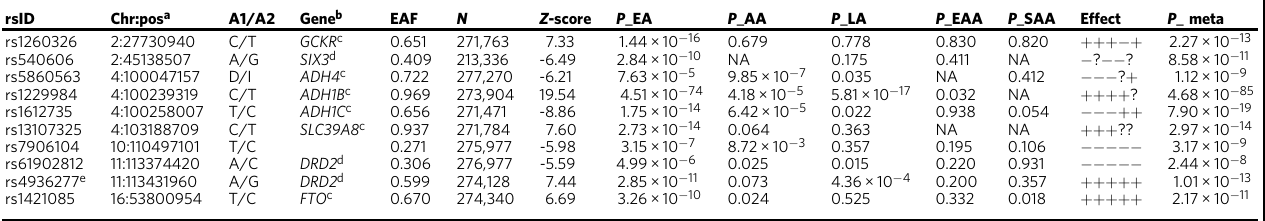
Table 2 Genome-wide signi fi cant associations for AUD in the trans-population meta-analysis